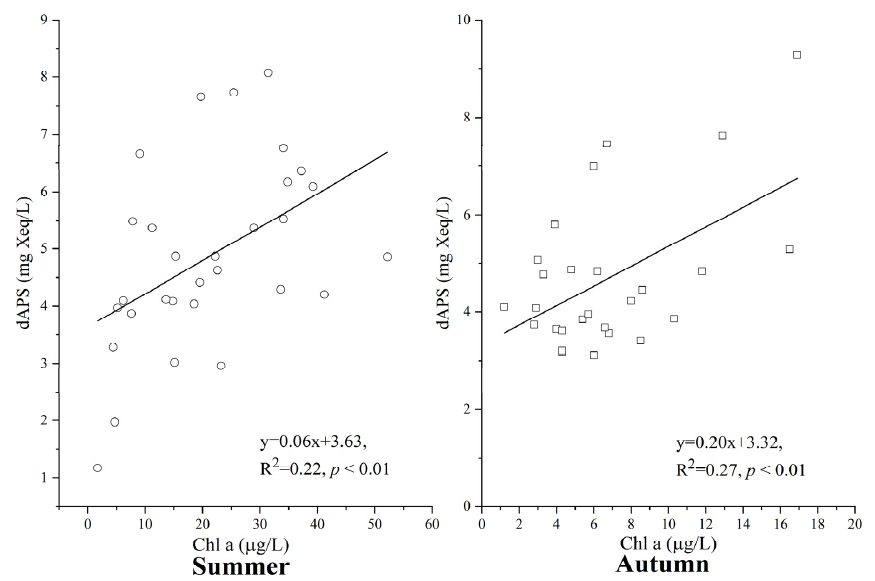
Figure 5. The relationship between dissolved acidic polysaccharides (dAPS) and chlorophyll a during summer and autumn.